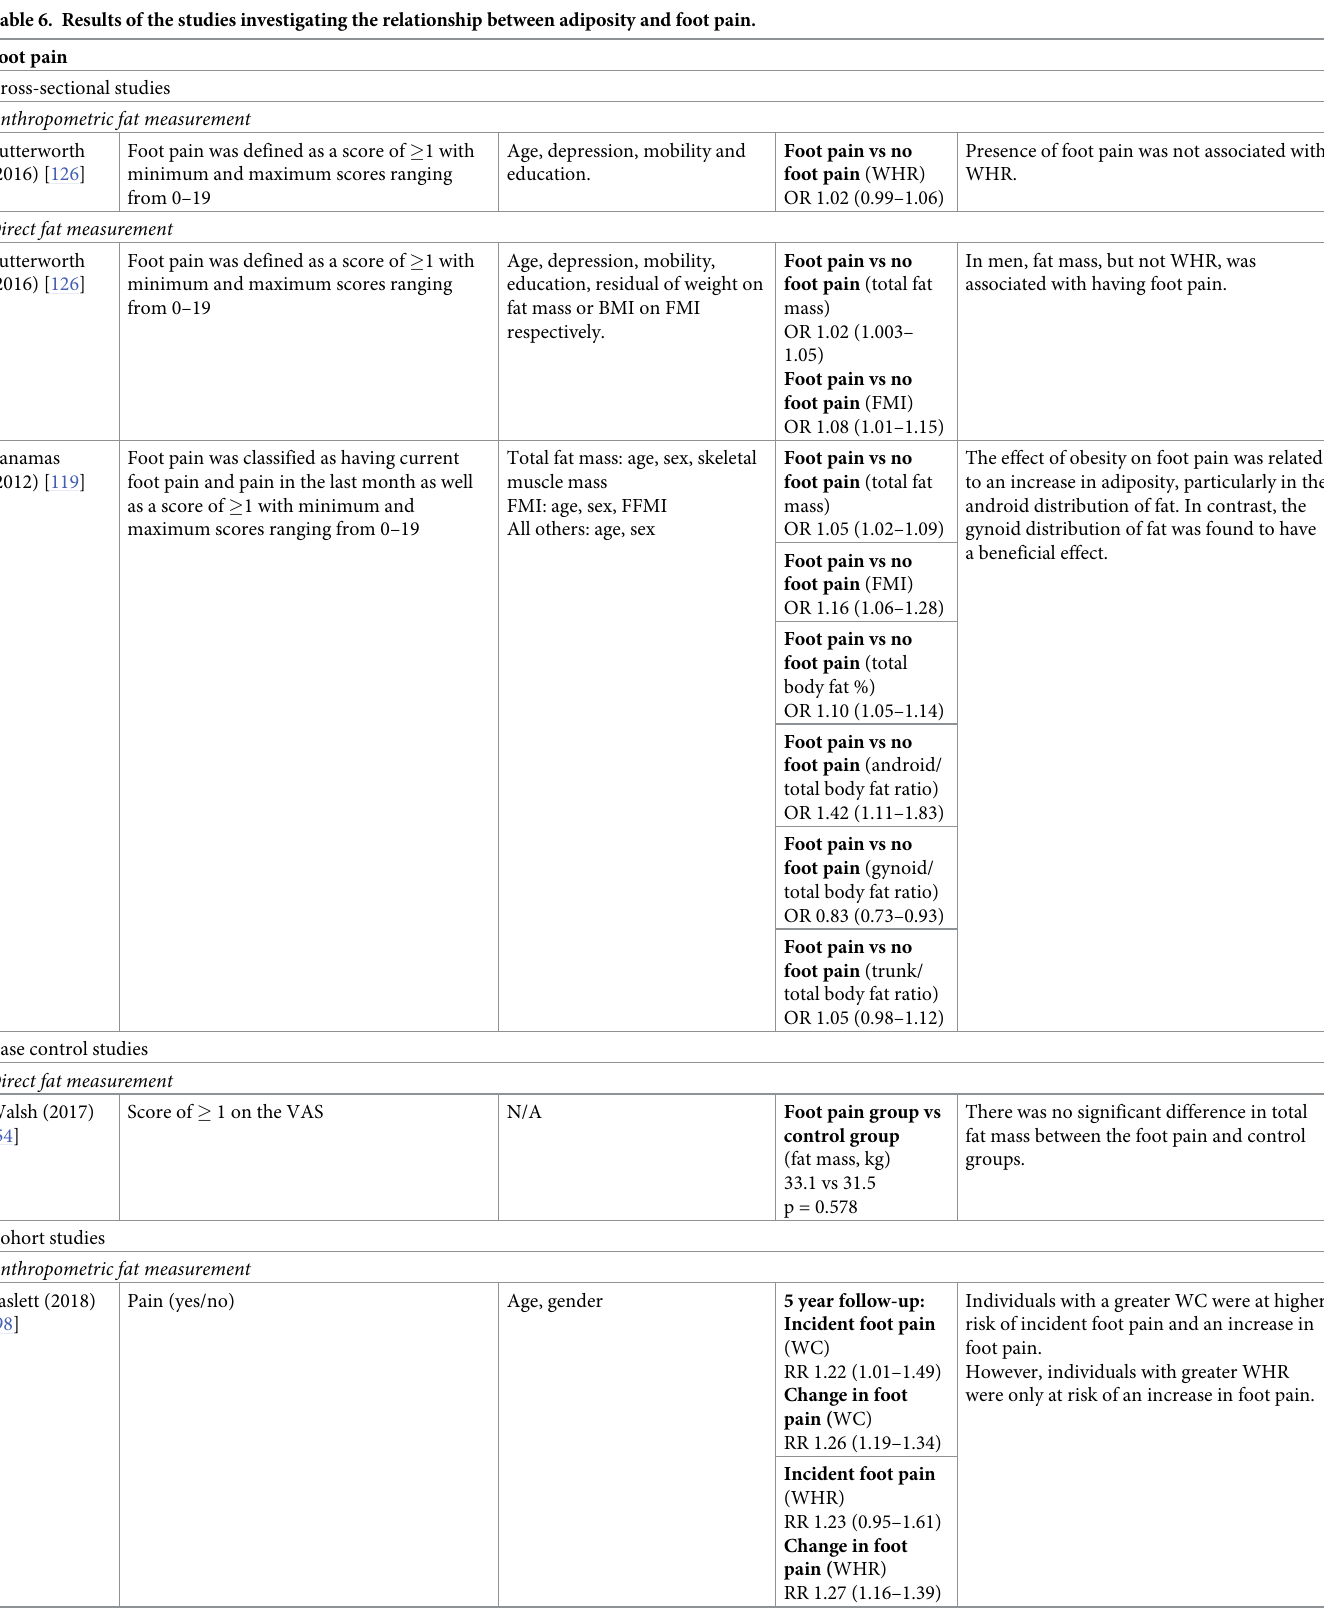
Table 6. Results of the studies investigating the relationship between adiposity and foot